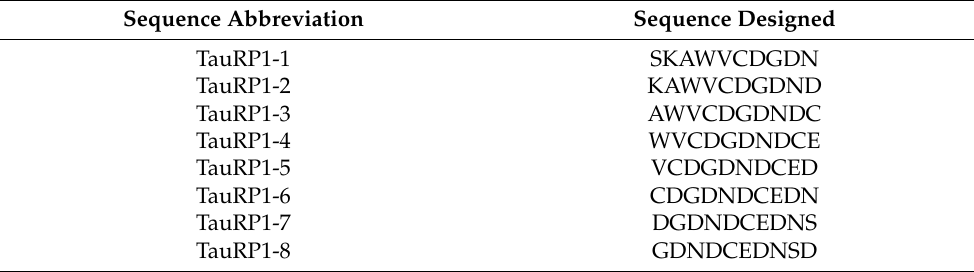
Table 2. Short peptide sequences designed derived from the 23-amino-acid sequence of the LPR1 binding